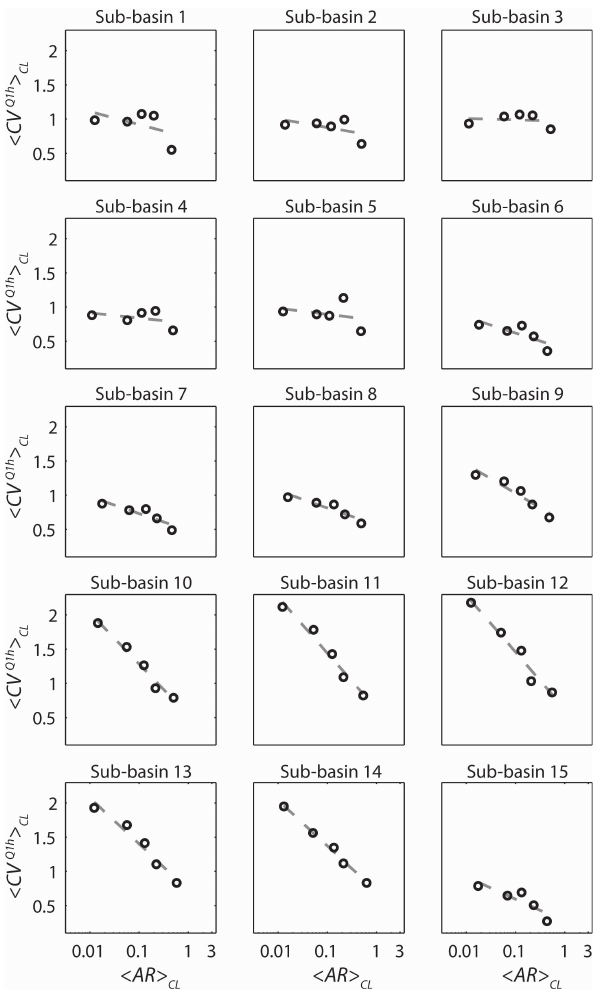
Fig. 7. Relation between ESF dispersion and AR (mmh − 1 ) in each sub-basin.